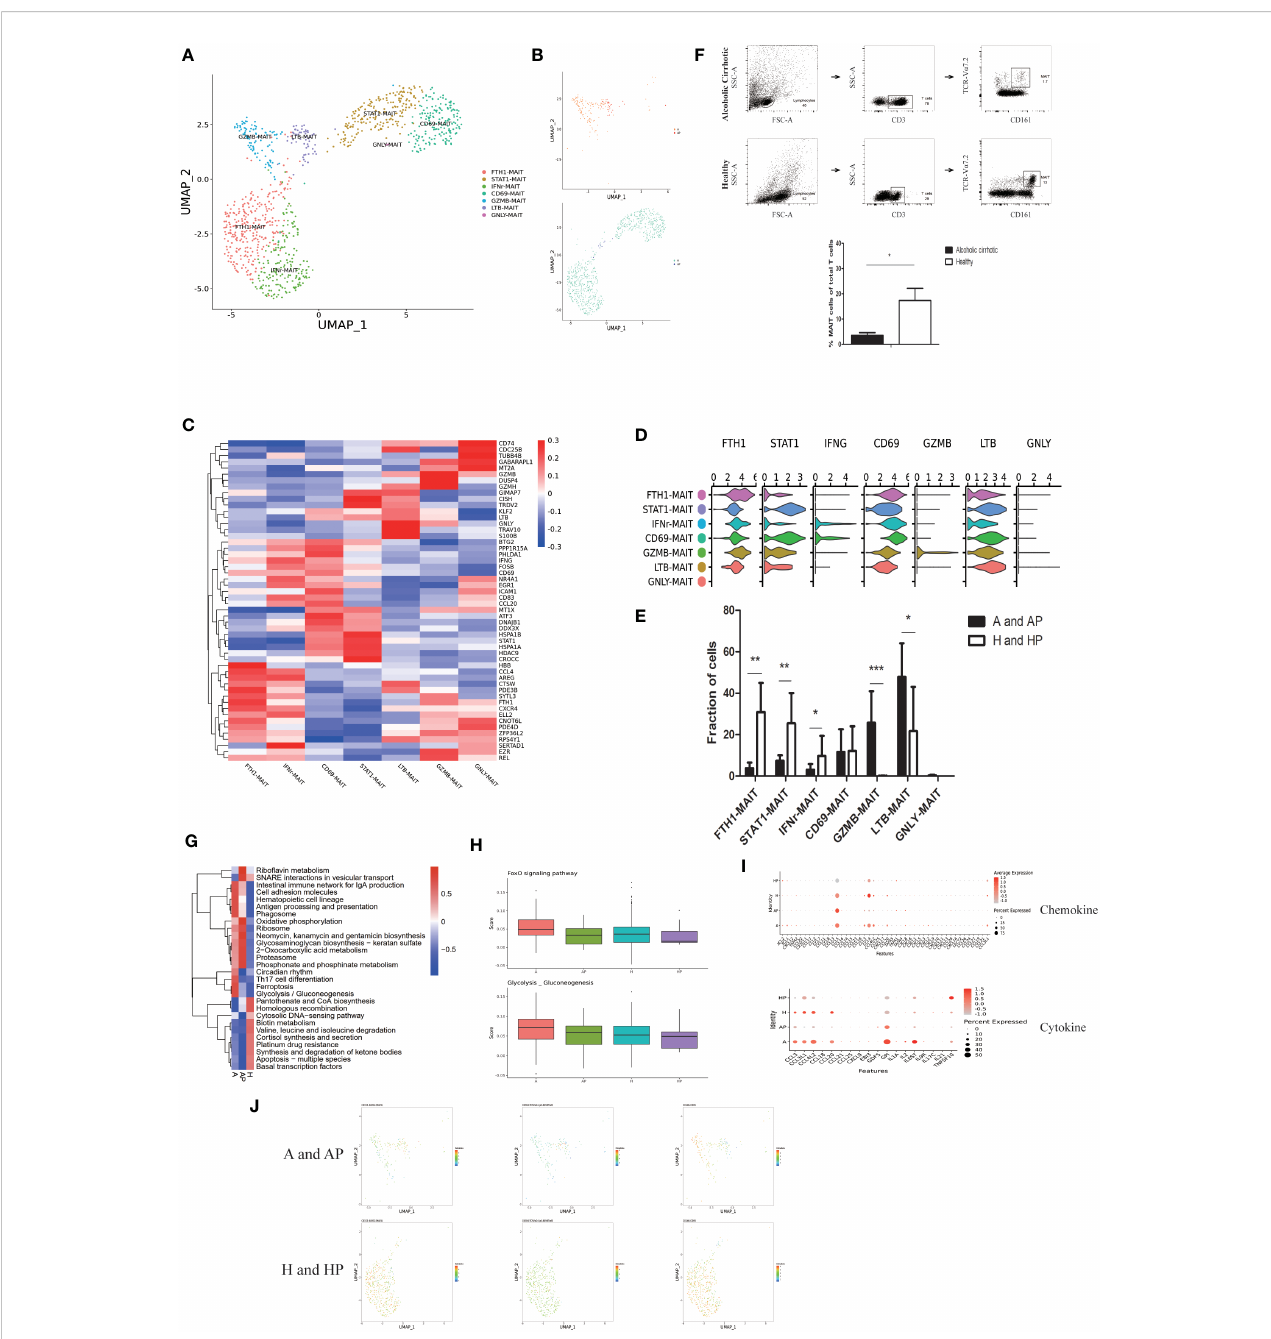
FIGURE 4 Identifying MAIT cell subpopulations. (A) Clustering of 969 mucosal-associated invariant T (MAIT) cells from fi ve liver tissue and peripheral blood samples (n = 2 healthy and n = 3 alcoholic cirrhosis) (B) Annotation of MAIT cells by patient ’ s condition. (C) Heatmap of MAIT cell cluster marker genes. (D) Scaled gene expression in MAIT cells. (E) Fraction of MAIT cells. (F) Flow analysis of MAIT cells in each group. (G) QuSAGE analysis of MAIT cells in the A, AP, and H groups. (H) Single-sample GSEA (ssGSEA) analysis of MAIT cells in the A, AP, H, and HP groups. (I) Cytokine and chemokine analyses of MAIT cells in the A, AP, H, and HP groups. (J) Proteomic analysis of KLRG1, CD69, and TCR. (*P < 0.05, **P < 0.01, ***P <